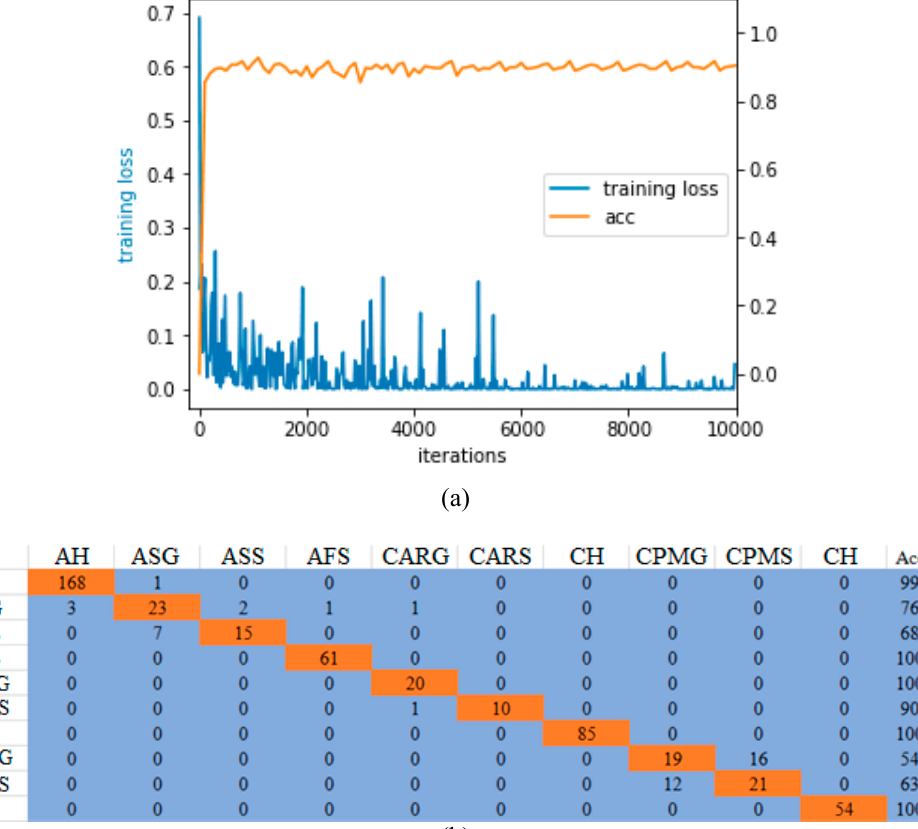
Figure 8. Trend graph of the loss function ( a ) and confusion matrix ( b ). ( 1 ) Apple healthy (AH); ( 2 ) Apple Scab general (ASG); ( 3 ) Apple Scab serious (ASS); ( 4 ) Apple Frogeye Spot (AFS); ( 5 ) Cedar Apple Rust genera (CARG)l; ( 6 ) Cedar Apple Rust serious (CARS); ( 7 ) Cherry healthy (CH); ( 8 ) Cherry Powdery Mildew general (CPMG); ( 9 ) Cherry Powdery Mildew serious (CPMS); ( 10 ) Corn healthy (CH).